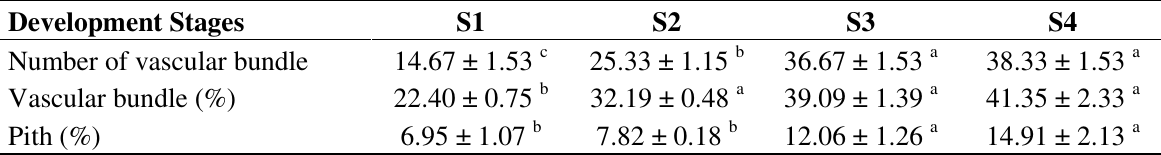
Table 3. Microstructure of inflorescence